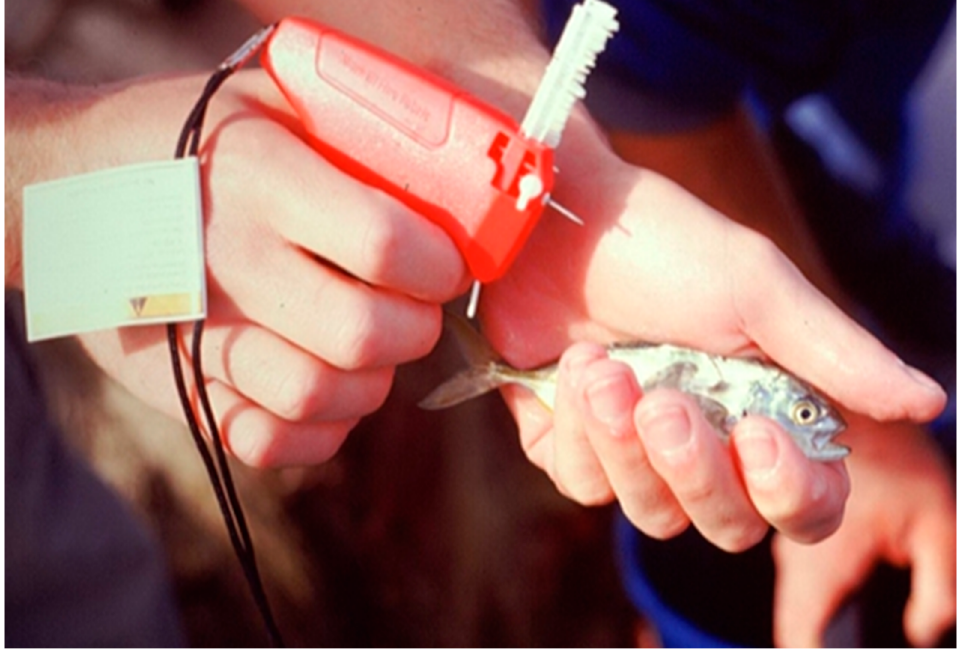
Figure 2. Tagging of a Caranxs crysos individual using a fine fabric gun (INC). Table 1. List of type and colour of tag used in the tagging experiment and percentage of sightings of tagged fish in the following censuses. SP = spaghetti tag, RE = rectangular tags, n = numbers of individuals tagged.